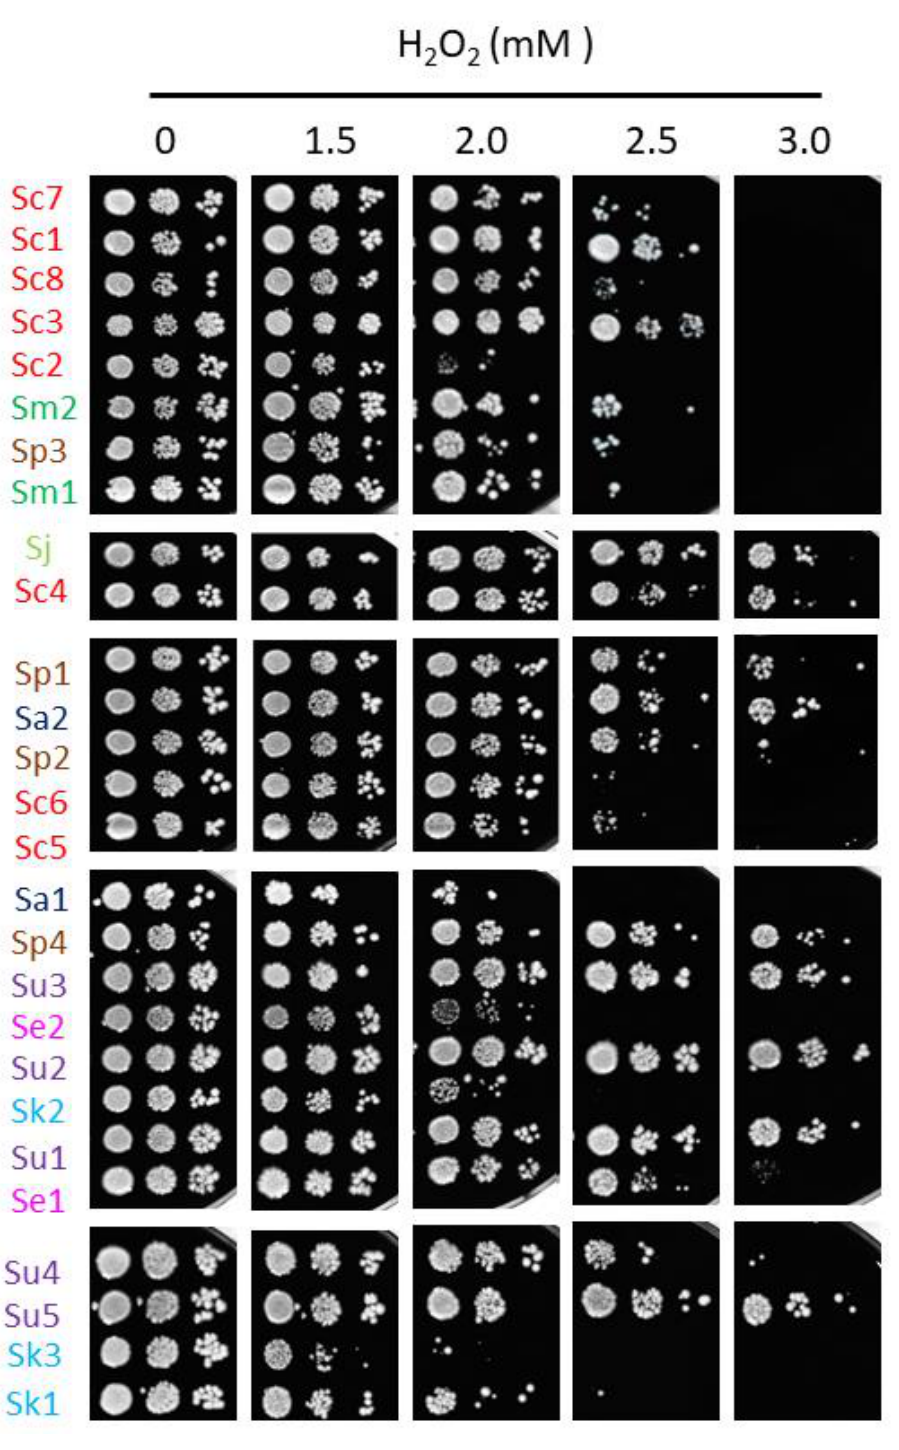
Figure 5. Growth of Saccharomyces strains in H 2 O 2 -containing media. Overnight precultures were diluted to an OD 600 of 0.1, 0.01 and 0.001, and spotted in SC plates with a range of H 2 O 2 concentra- tions. Plates were incubated during 7 days at 20 °C and then photographed. Strains are sorted based on MIC values and species-specific colors are used as in the above figures.